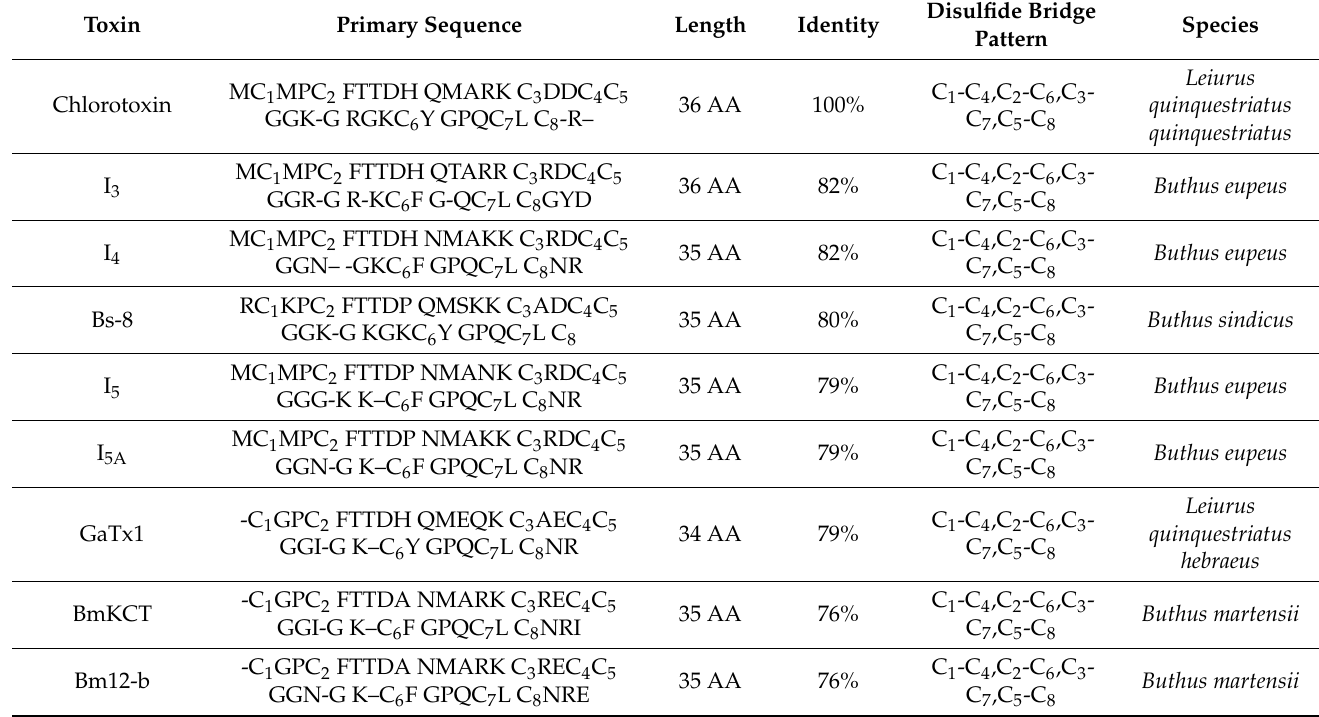
Table 1. Alignment of amino acid sequences of chlorotoxin-like peptides. Alignments were performed using @TOME V2. Percentage sequence identity is provided by comparison with chlorotoxin sequence. Disulfide bridge pattern is provided when